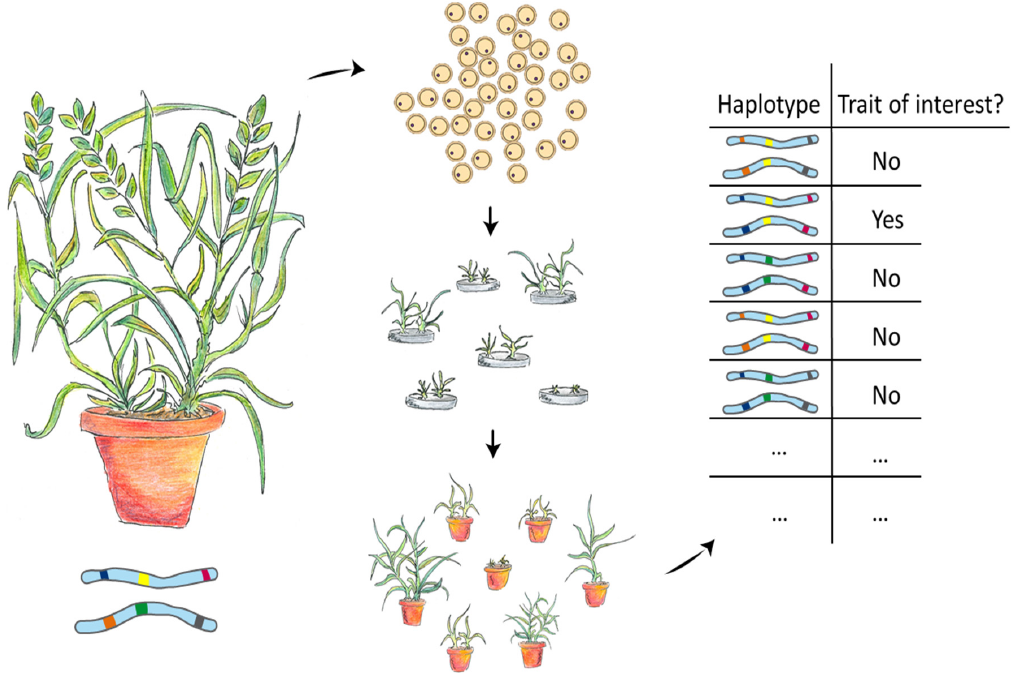
Figure 2. Schematic representation of a direct haplotype mapping strategy by DH induction of microspores derived from a single, heterozygous genotype exhibiting a trait of interest. Through recombination during meiosis in the donor plant, the microspore population represents a large diversity of possible haplotypes. Both donor and microspore ‐ derived DH plants are genotyped and phenotyped so that statistical methods can be used to infer the haplotype associated with the trait of interest (in this case the dark blue, yellow, and red alleles).